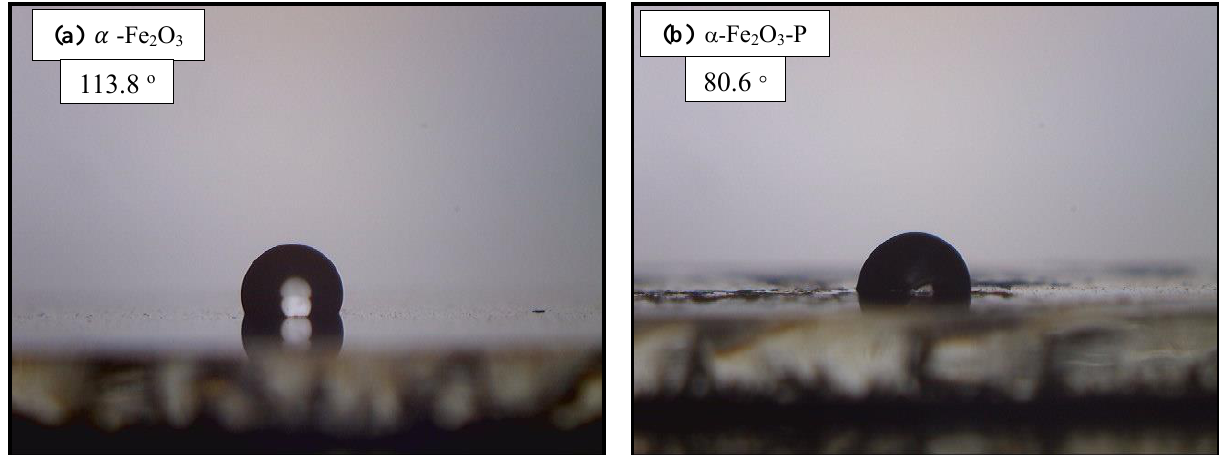
Figure 6. The Contact Angle Measured between the Surface of  -Fe 2 O 3 Thin Film and the Water Droplet (a) prior to Plasma Treatment and (b) following Plasma Treatment (  -Fe 2 O 3